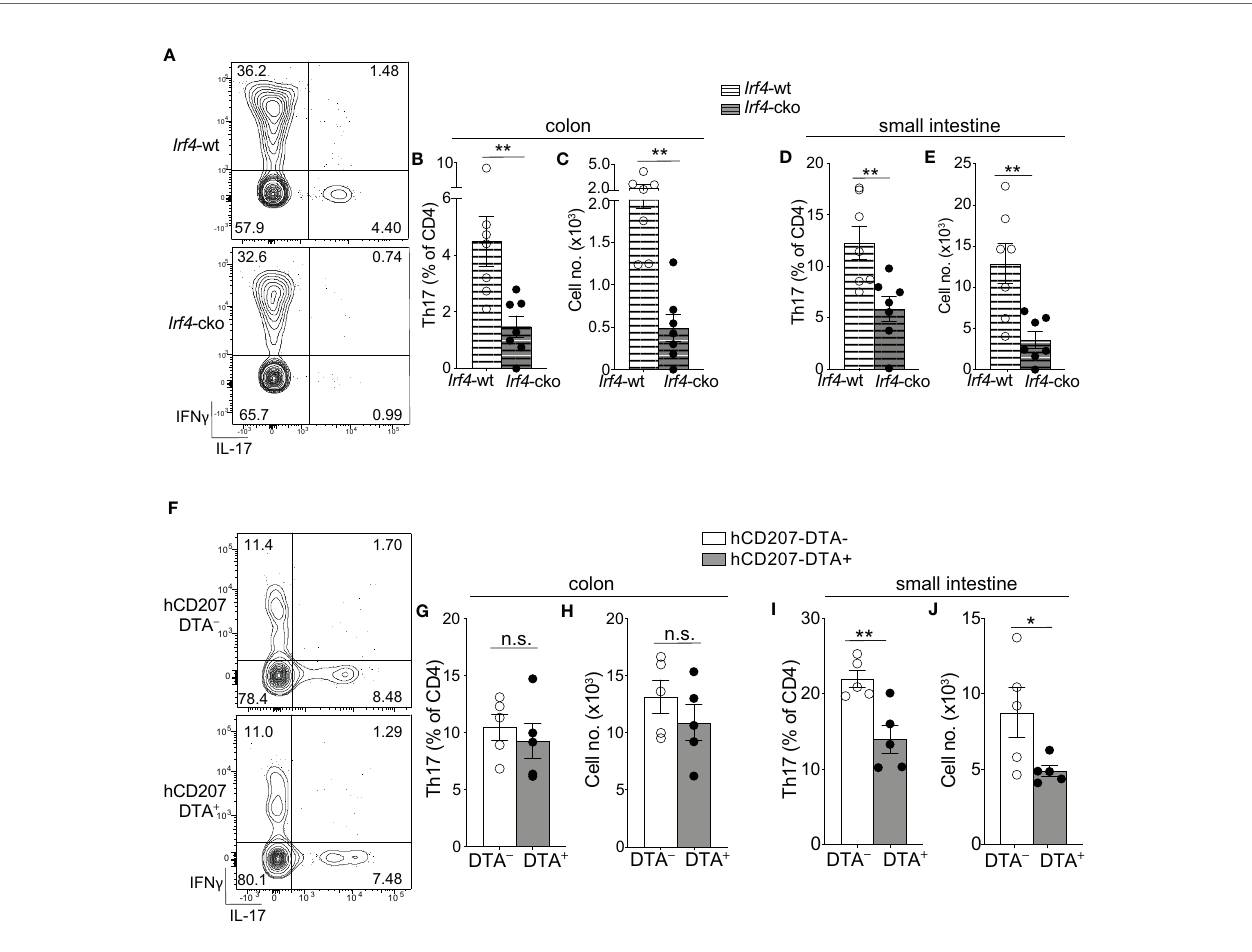
FIGURE 5 | Colon-speci fi c CD14 + CD24 + CD88 – APCs are required for Th17 immunity in the colon. (A – E) C-LP or SI-LP CD4 T cells were analyzed from co-housed littermate Irf4 -wt and Irf4 -cko mice. (A) Representative plot of C-LP CD4 T cells from mice of the indicated genotype analyzed for IFN g and IL-17 production. The percent (B) and absolute cell number (C) of C-LP Th17 cells from all mice tested. The percent (D) and absolute cell number (E) of SI-LP Th17 cells in Irf4 -wt and Irf4 -cko mice analyzed in (B, C) . Data in (B – E) was combined from three independent experiments. (F – J) C-LP and SI-LP CD4 T cell populations were analyzed from co-housed littermate hCD207-DTA – and hCD207-DTA + mice as in (A – E) . Representative plot of C-LP CD4 T cells (F) , the percent (G) and absolute cell number (H) of C-LP Th17 cells, and the percent (I) and absolute cell number (J) of SI-LP Th17 cells. Data are representative of three independent experiments. Error bars represent mean ± SEM. * p < 0.05, ** p < 0.01, n.s., not signi fi cant (unpaired Student ’ s t